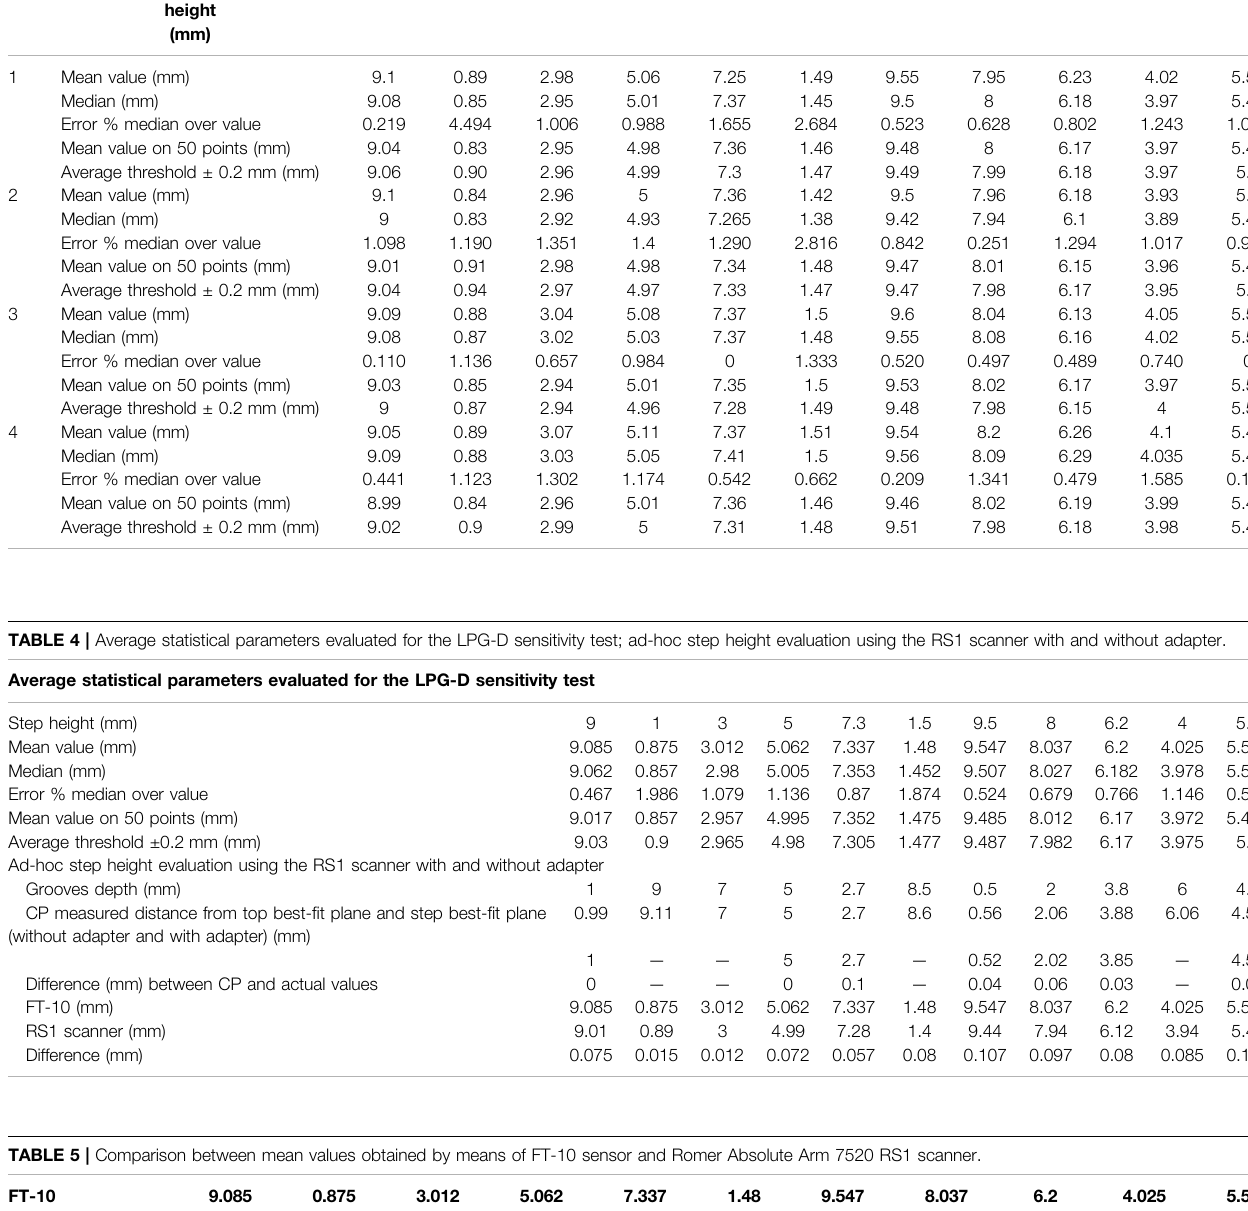
TABLE 3 | Data of four tests evaluated for the LPG-D sensor sensitivity test. Step height